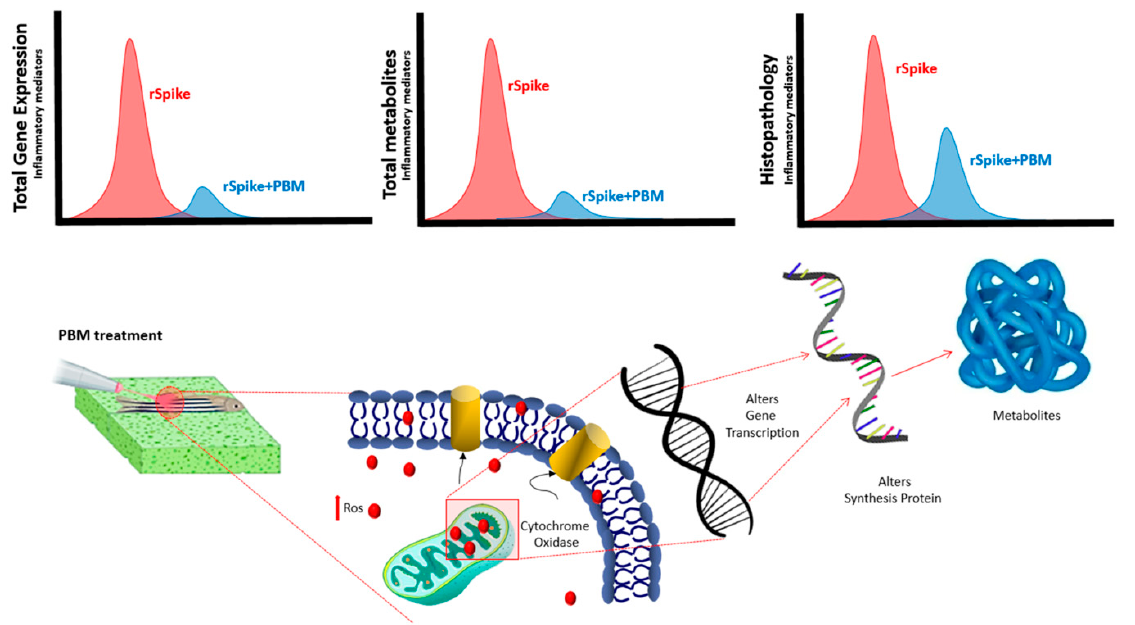
Figure 9. Summary of the effects of recombinant Spike protein (rSpike) and PBM treatment in gene expression, metabolites and histopathology. Analyses were performed using bioassays at 6 and 24 h after treatments.